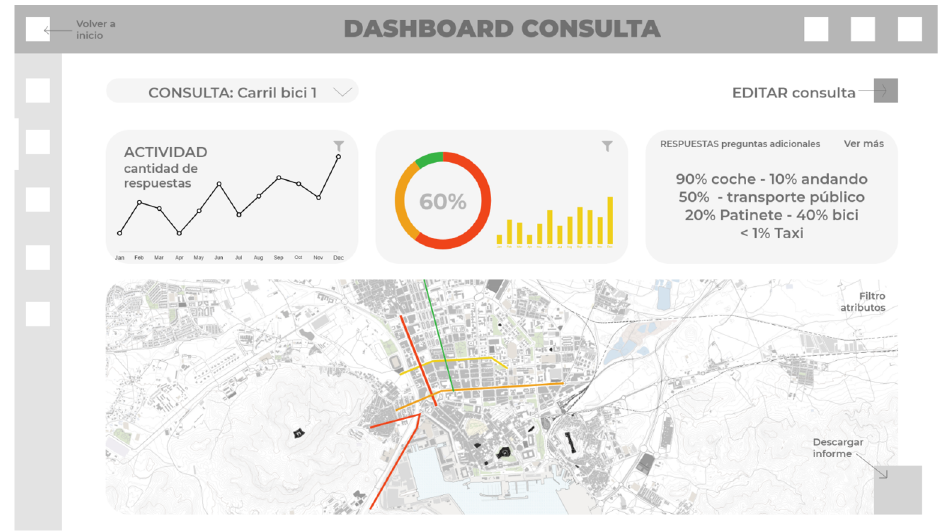
Figure 3. Example of survey software for spatial analysis of bike lane activity during the pandemic.